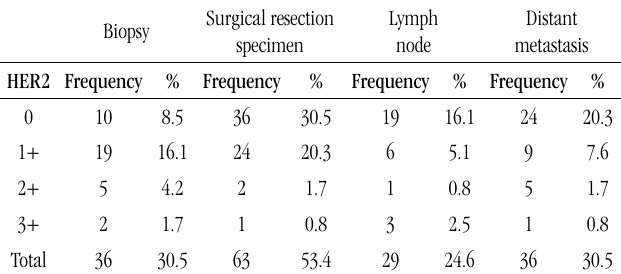
tABLE 2 – Frequency of HER2 expression in biopsies, surgical resection specimens, perigastric lymph node metastasis and distant metastasis Surgical resection Biopsy